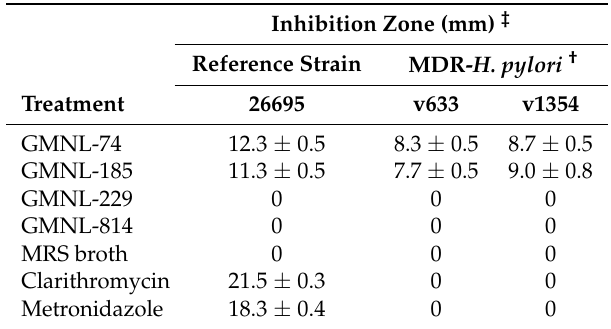
Inhibitory effect of probiotic Lactobacillus spp. and multidrug-resistant (MDR) isolates v633 and